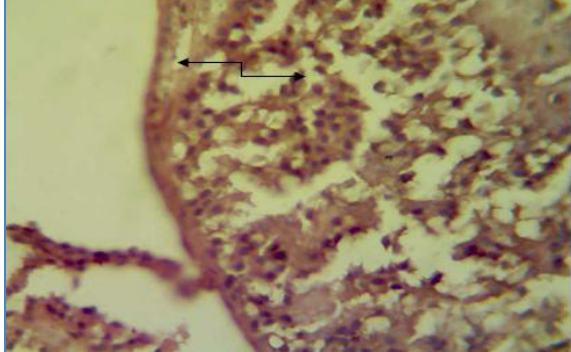
Figure, 2: Section in pituitary gland of animal treated with cadmium chloride (G1) shows marked depletion of the cells of pars distalis due to necrosis and apoptosis left large multiple spaces in their parenchyma ( ), (H and E stain 40X).